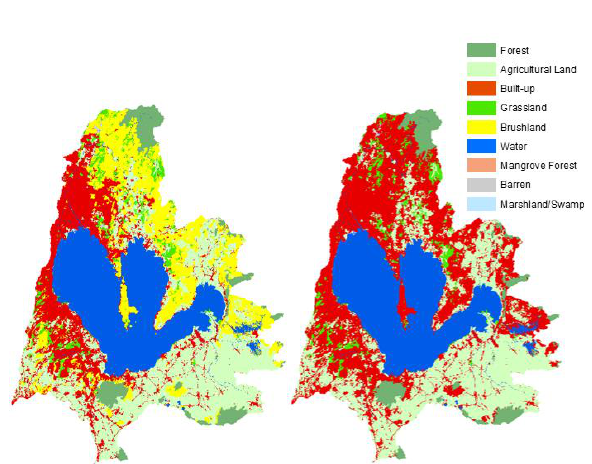
Figure 7 . Original (left) and urbanized (right) 2015 land covers. In 2015, the land cover of Laguna de Bay Basin was composed of 18% built-up and 19% brushland. By hypothetically converting brushland to urban areas, the new land cover and percentages for each land cover classification.